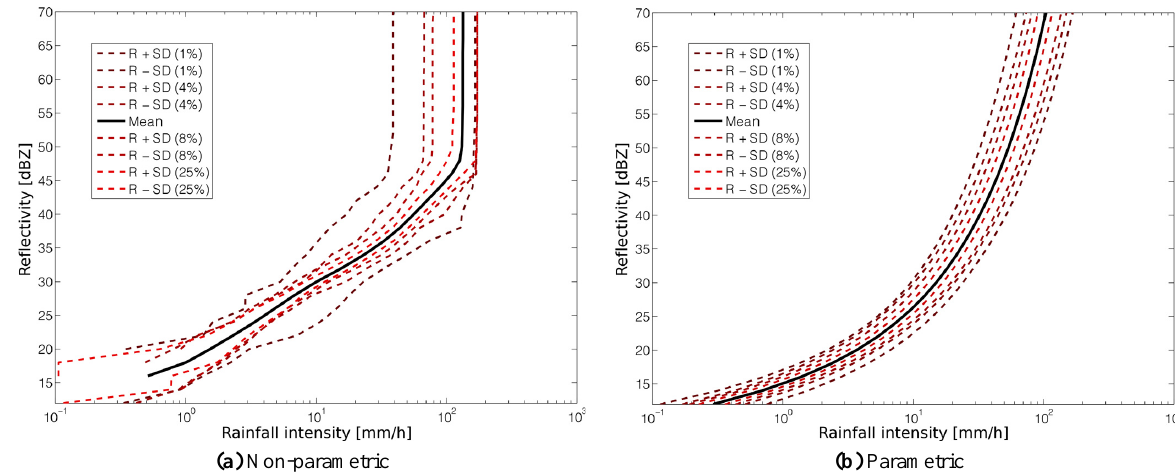
Fig. 10. The new Z/R relation (solid middle line), as obtained from WPMM for the full dataset. The broken lines represent plus and minus one standard deviations from the Z/R when calculated by population from 1% to 25% sub-samples. The left example (a) is the new Z/R relation obtained by non-parametric fitting whereas the right one (b) correspond to the parametric fit.